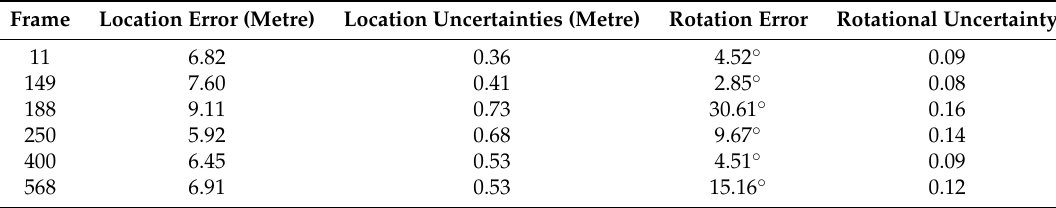
Table 3. The comparison of the errors and estimated uncertainties for the frames of Figure 11.